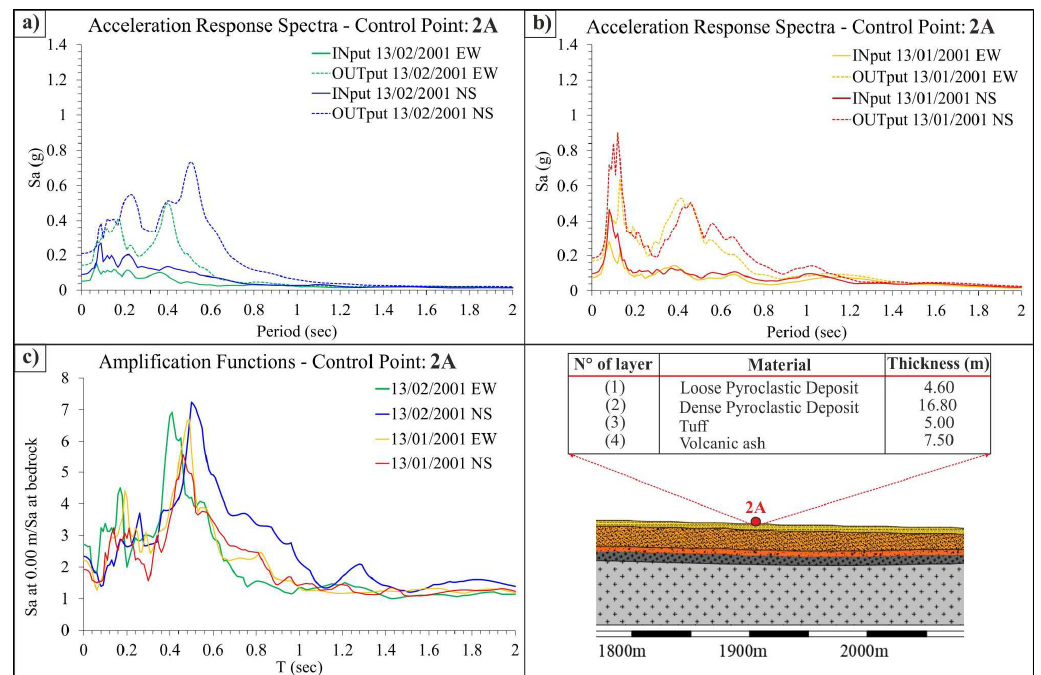
Figure 14. Section AA′: numerical control point 2A spectral responses obtained by 2D numerical analyses using LSR2D software. ( a ) Comparison among the SA of the two components of the 13 February 2001 earthquake. ( b ) Comparison among SA of the two components of the 13 January 2001 earthquake. ( c ) Amplification functions related to the four input motions.